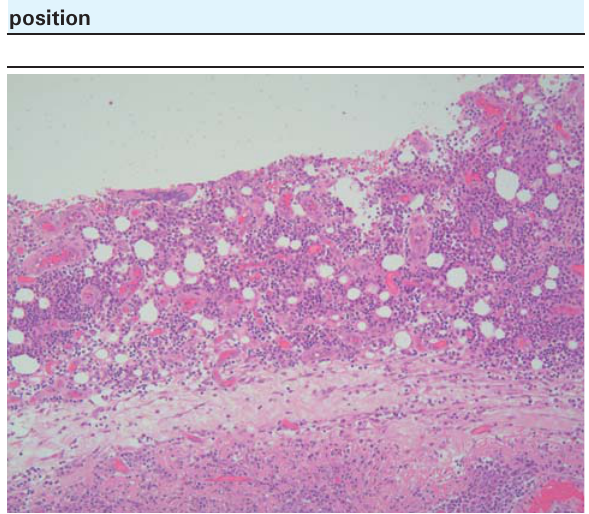
Figure 2. Histology showing chronic infl ammation in the connective